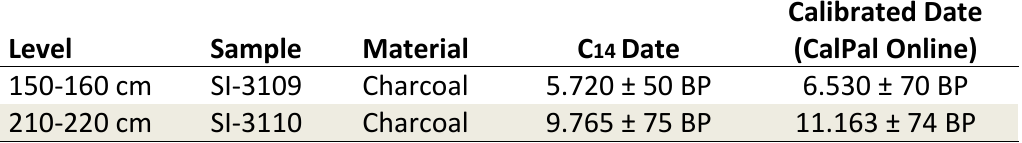
Table 1. Gruta das Araras site dates. Bold date related to analyzed